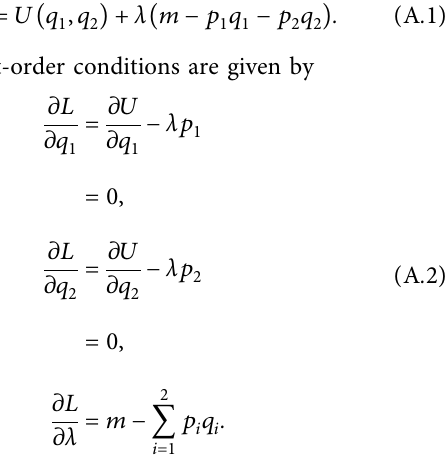
− 1 and the region � 2 , c � 1 . 5 , r 1 2